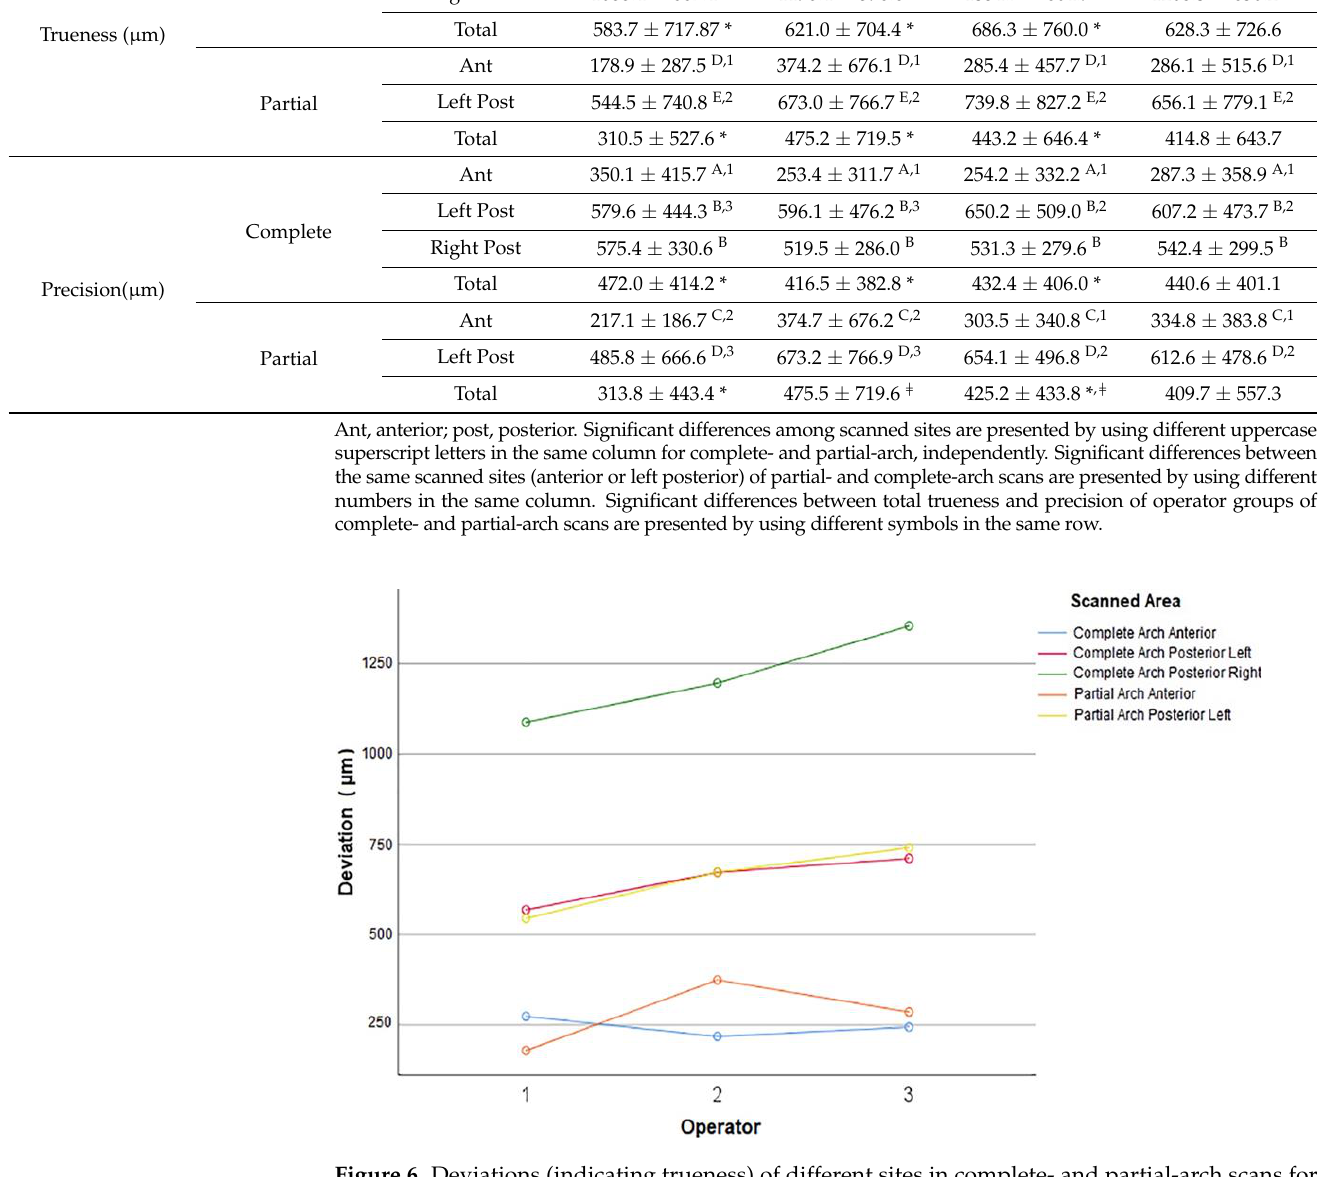
Figure 6. Deviations (indicating trueness) of different sites in complete- and partial-arch scans for each operator.